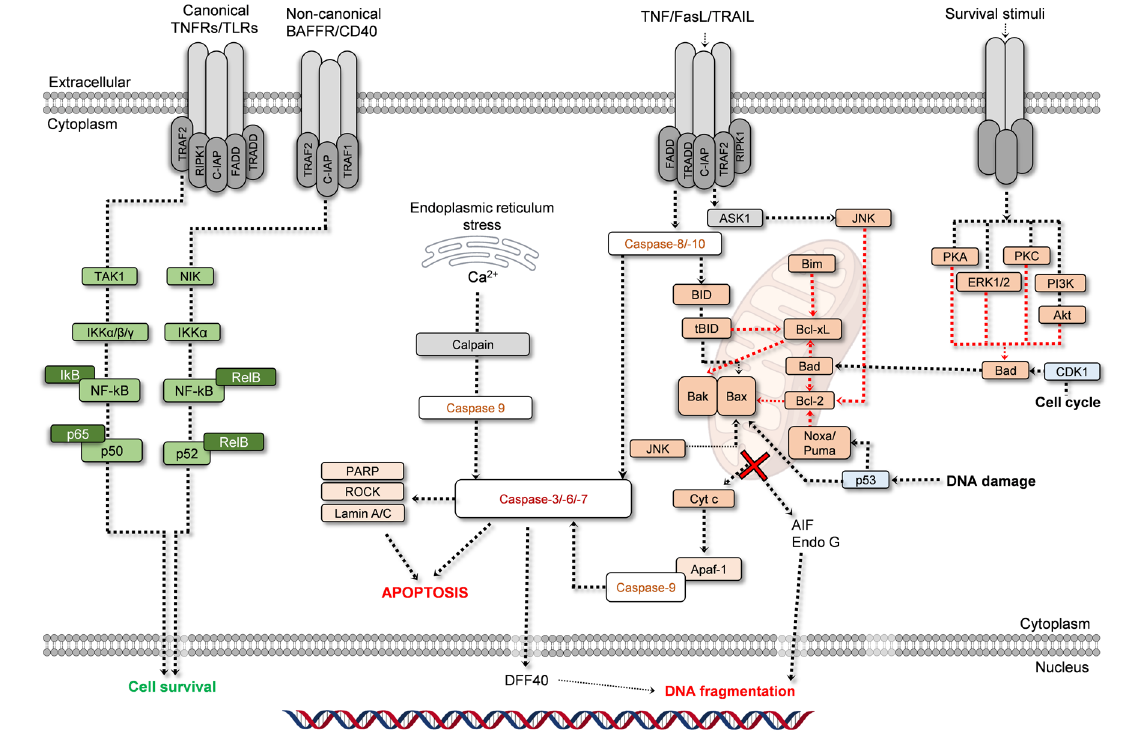
Figure 2. Schematization of main intervenients participating in key signaling pathways in cell survival and apoptosis processes. Adapted from [37–44], and from illustrations courtesy of Cell Signaling Technology, Inc. [45–47]. The red arrow means inhibition; the black arrow means inducer. Abbreviations: ASK1, apoptosis signal-regulating kinase 1; c-IAP, cellular inhibitor of apoptosis; FADD, Fas-associated death domain; TRADD, tumor necrosis factor receptor type 1-associated death domain; TRAF, TNF receptor-associated factor. All other abbreviations are mentioned in the text.